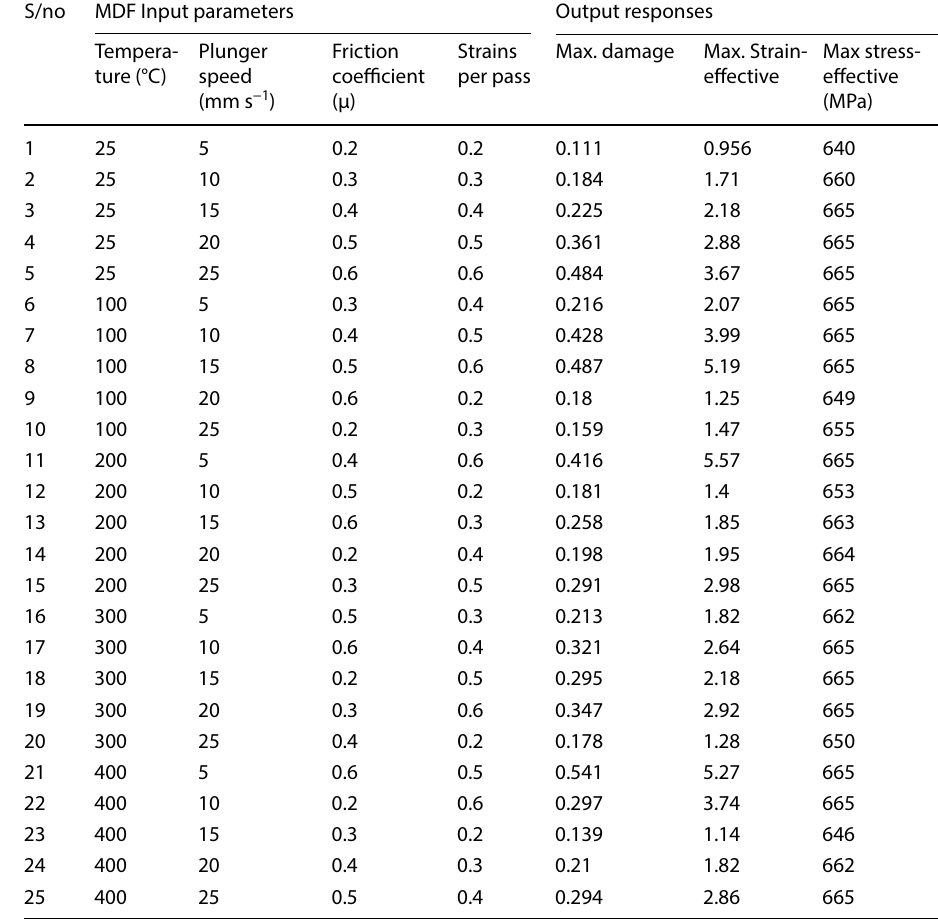
Table 3 Table of Taguchi response-output L25 orthogonal